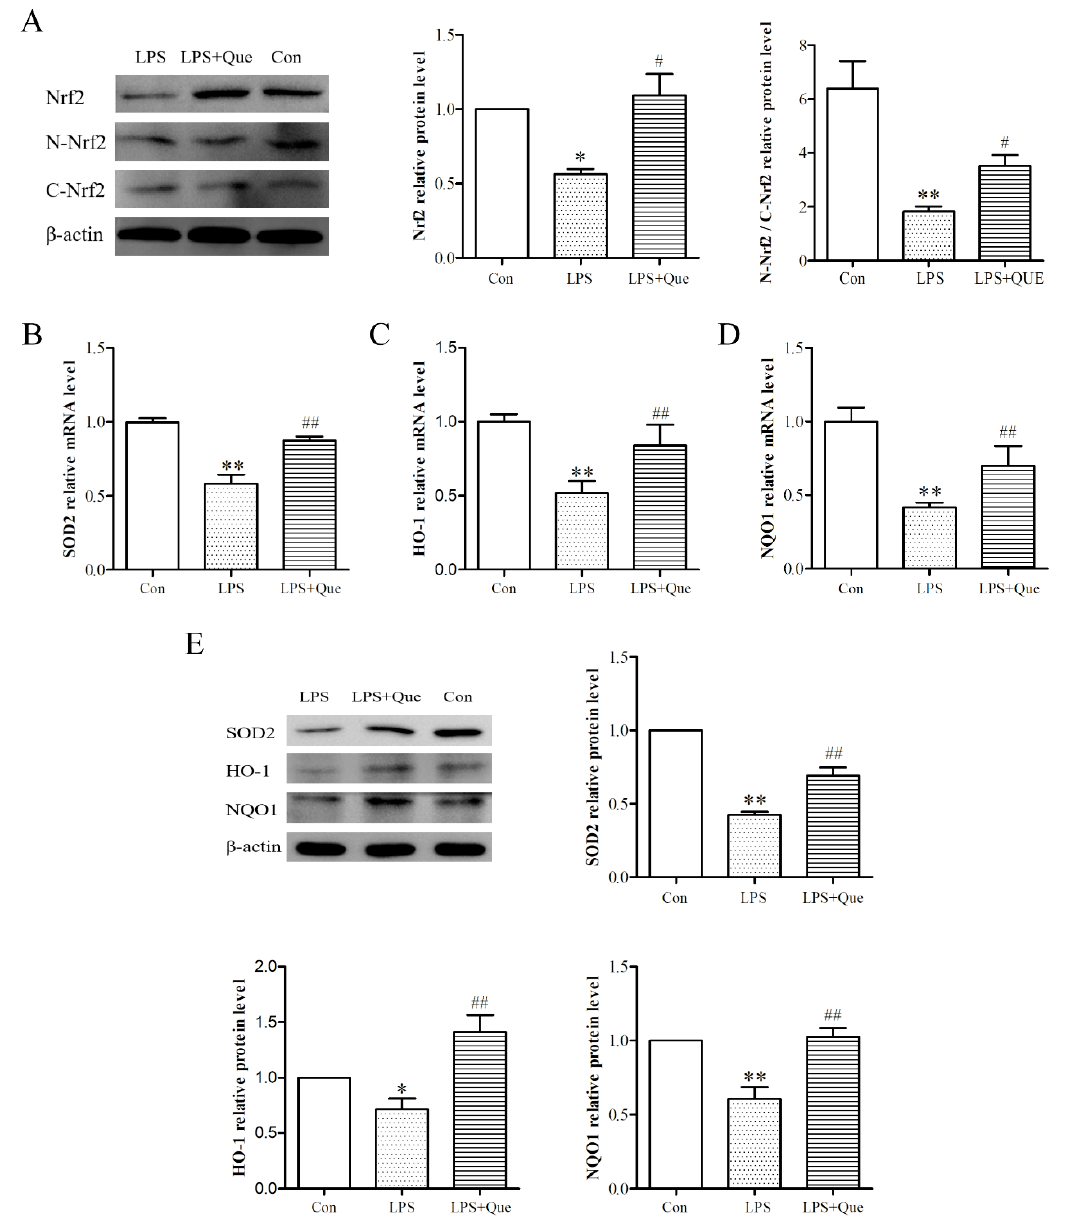
Figure 3. The effects of quercetin on nuclear factor erythroid 2-related factor 2 (Nrf2) activation and downstream genes. ( A ) The relative protein levels of Nrf2, N-Nrf2, and C-Nrf2. The relative mRNA levels of manganese superoxide dismutase (SOD2) ( B ), heme oxygenase-1 (HO-1) ( C ), and NAD(P)H dehydrogenase quinone 1 (NQO1) ( D ). ( E ) The relative protein levels of SOD2, HO-1, and NQO1. Values are shown as mean ± SEM. ** p < 0.01 or * p < 0.05 compared with the Con group. ## p < 0.01 or # p < 0.05 compared with the LPS group.